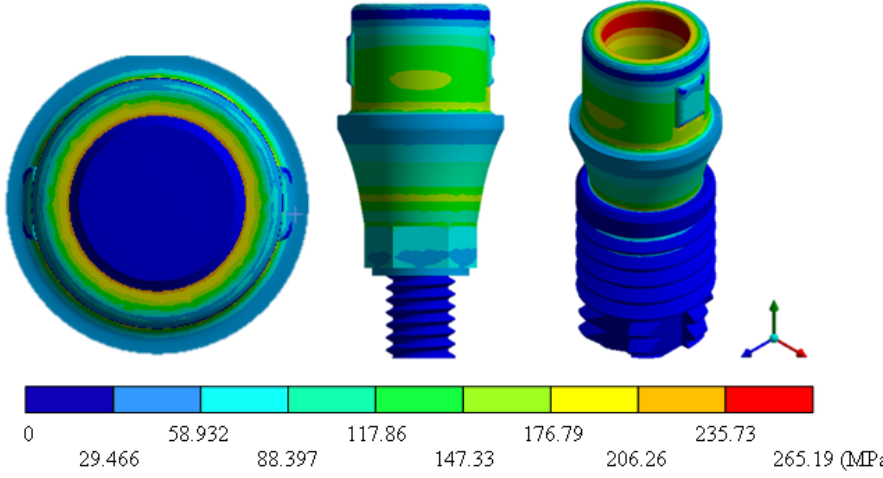
Figure 20. Von Mises stress for Universal-type implant (ZrO 2 ).